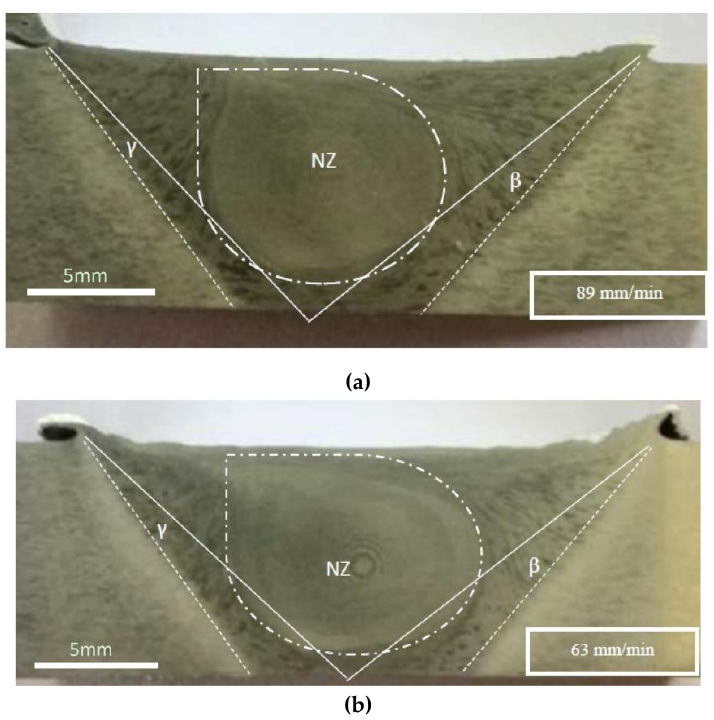
Figure 6. Cross-section macrostructure of butt joint section AA6061-T6 Al alloy at different welding speeds. ( a ) 89 mm/min welding speed ( b ) 63 mm/min welding speed.